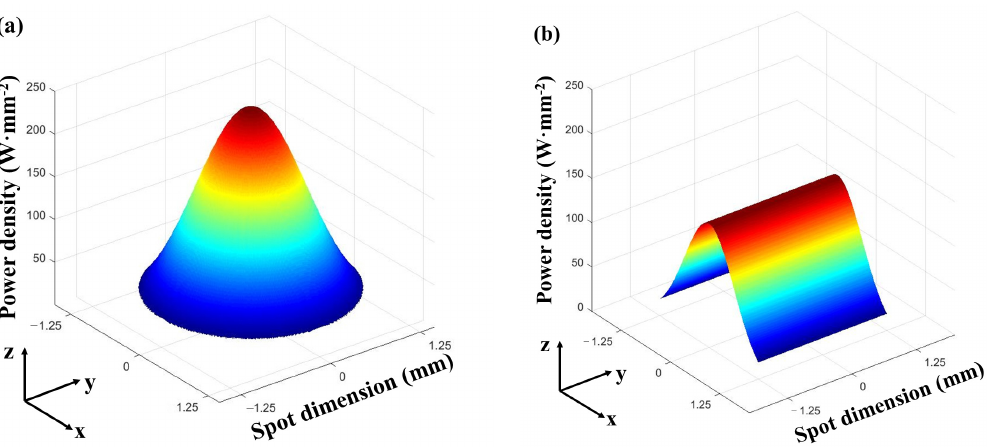
Figure 2. Power density distributions of the two laser beam profiles used when laser power is 600 W.